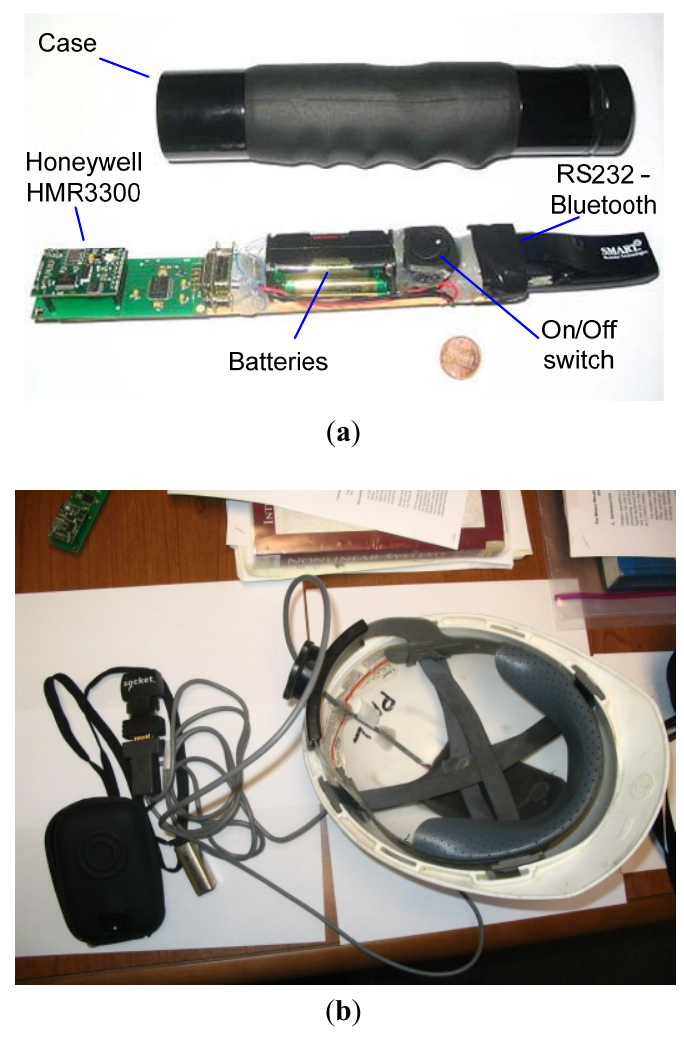
Figure 5. Prototypes built to conduct preliminary experimentation on the pointing and marking system ( a ) Handheld pointer; ( b ) Electronic compass in line with the helmet orientation (forehead) and wired (RS232) to rs232-bluetooth converter powered with a 12 V